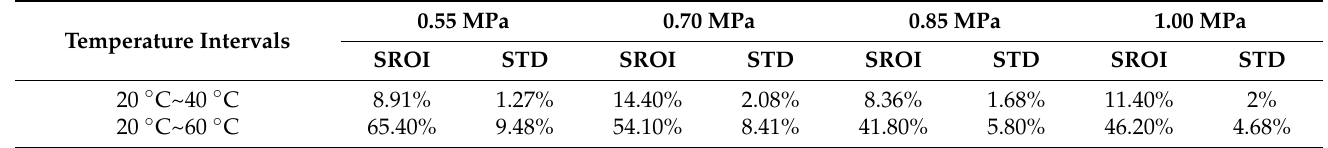
Figure 7. Effect of temperature on time–strain creep curves at the same stress level: ( a ) 0.55 MPa; ( b ) 0.70 MPa; ( c ) 0.85 MPa; ( d ) 1.00 MPa. Table 3. The relative strain growth rate at different temperature intervals (for 20 °C).